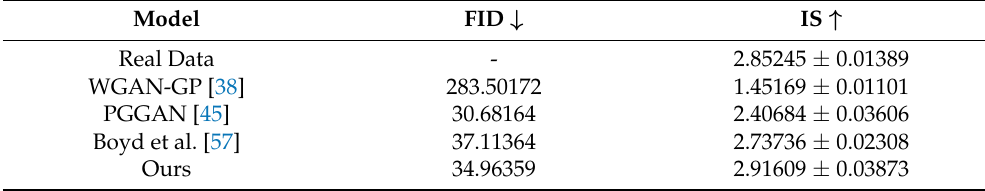
Table 2. The comparison of quantitative evaluation through FID and